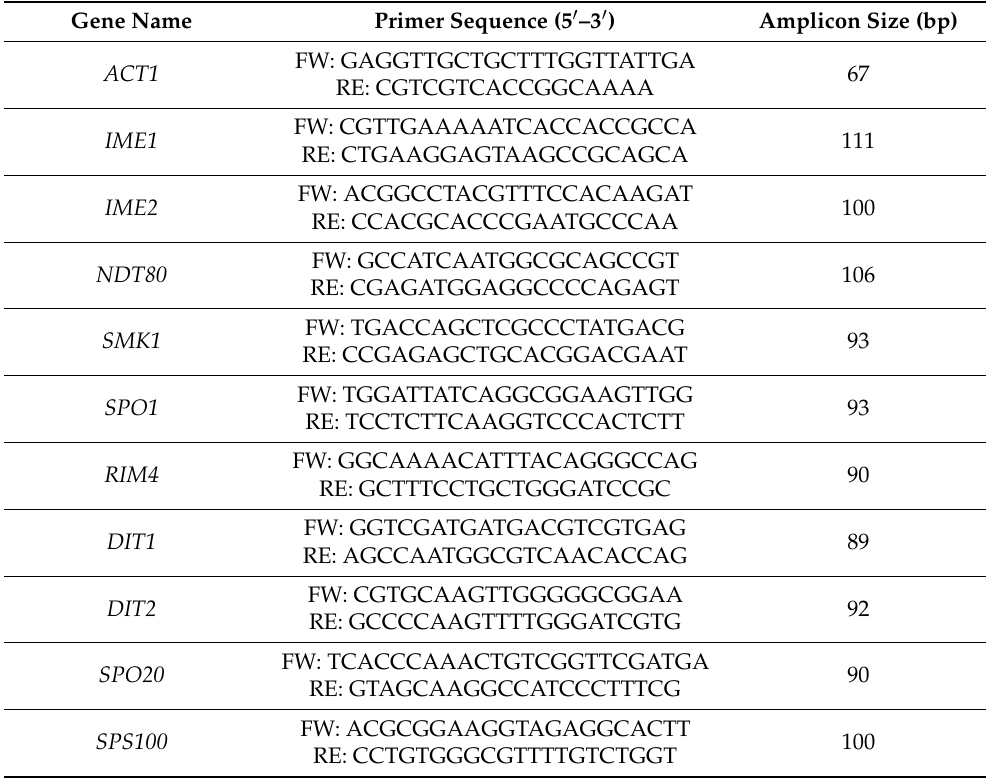
Table 1. List of primers used in this